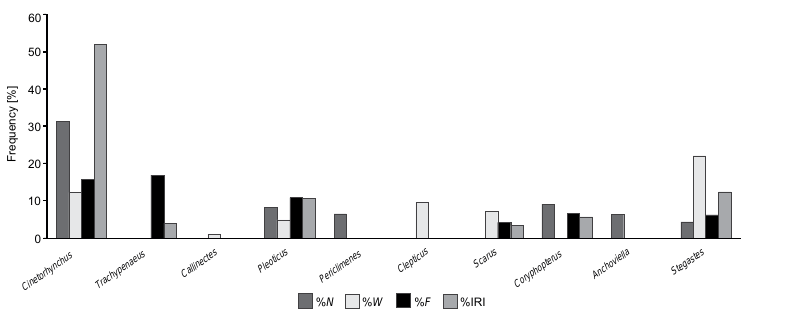
Fig. 4. Diet composition of red lionfi sh, Pterois volitans , on the genus level; % N = percentage by number, % W = percentage by weight, % F = frequency of occurrence, %IRI = index of relative importance %IRI